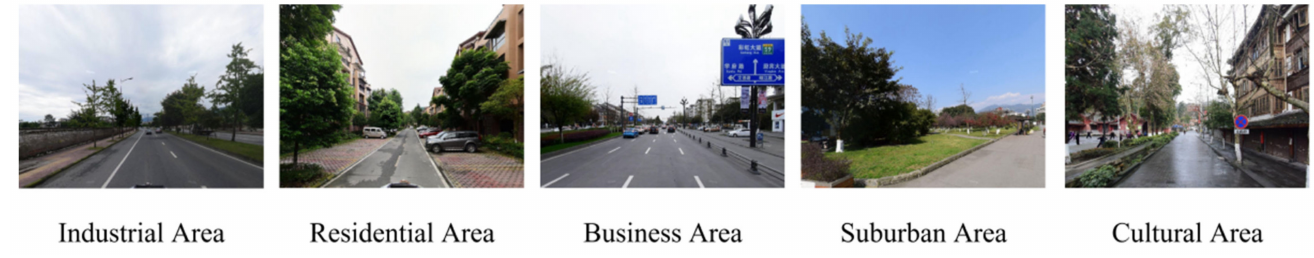
Figure 4. An example of functional